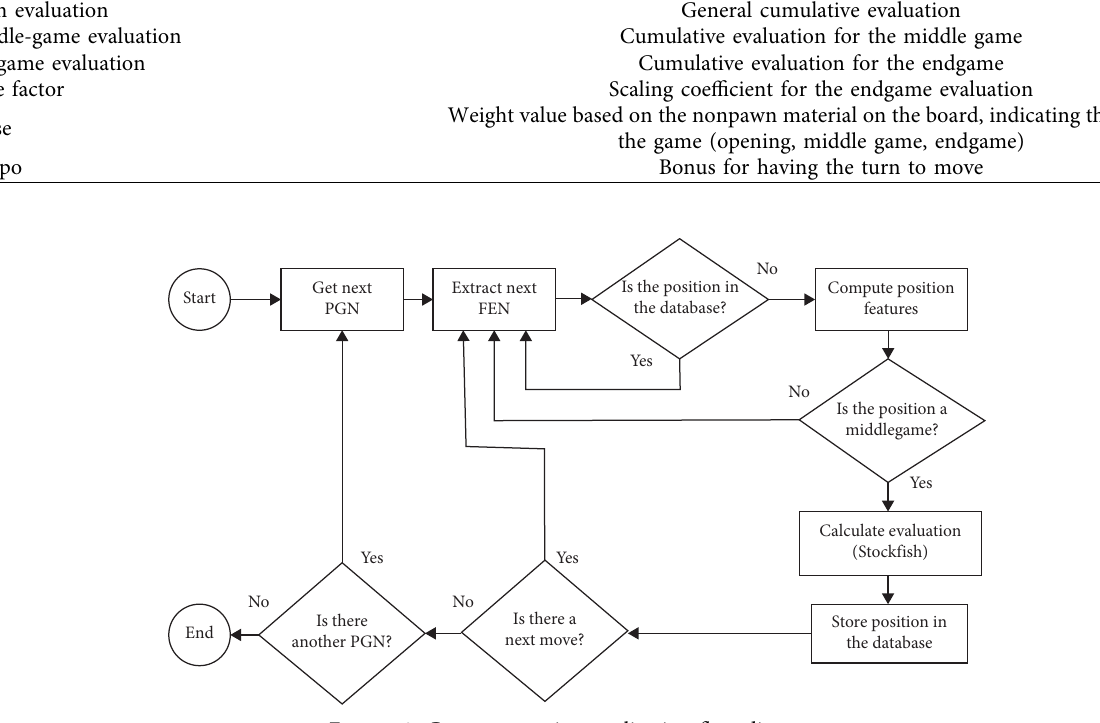
Figure 3: Game processing application fow diagram.